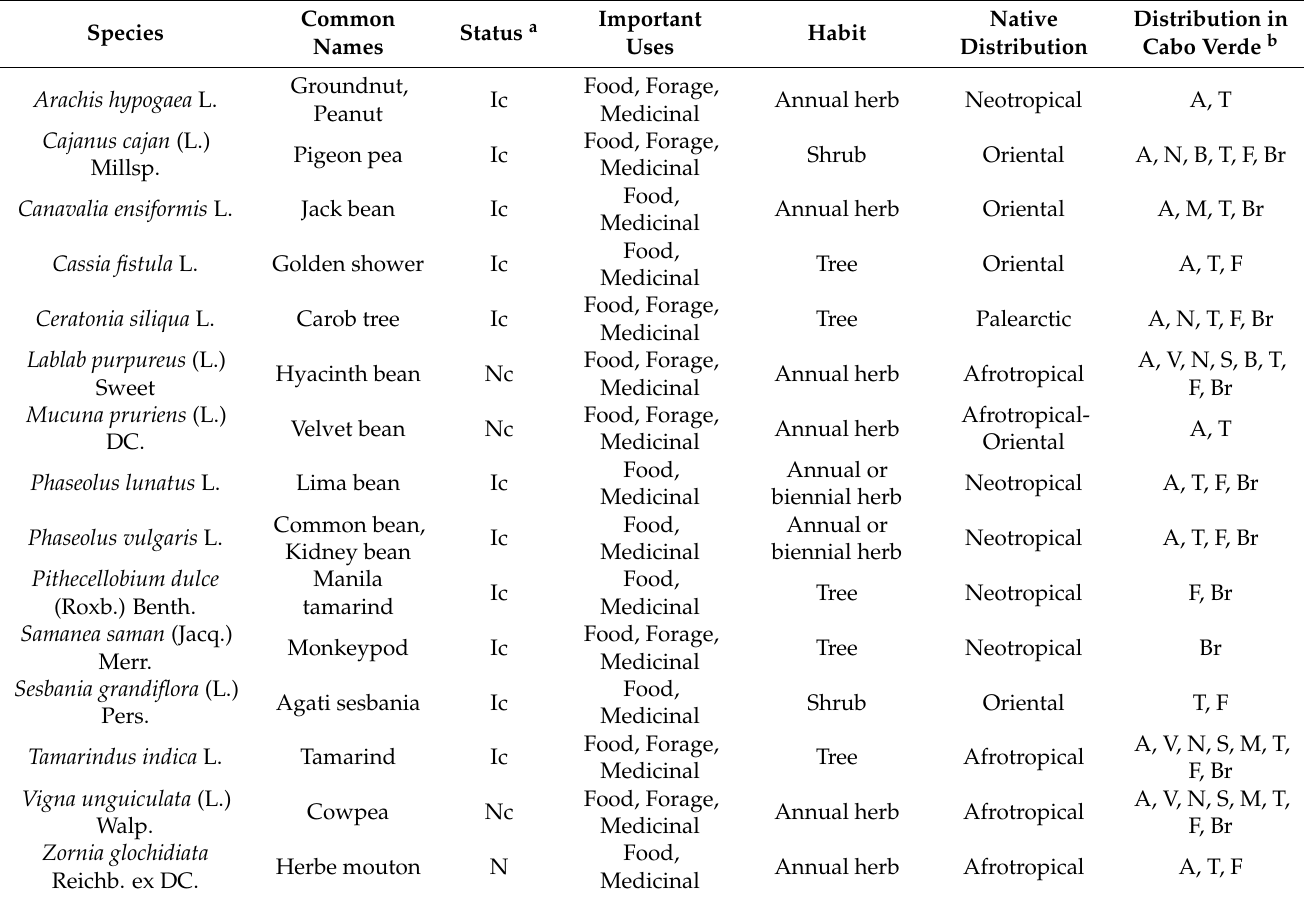
Table 1. Food legume species in Cabo Verde: scientific name, common name, status, important uses in Cabo Verde, native distribution, and distribution in Cabo